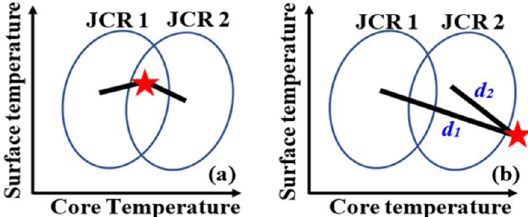
Figure 4. Visual interpretation of fault detection and diagnosis (FDD) algorithm using JCRs. Note that ( a ) represents that a pair of measurements can be found in the overlap of the JCRs, and ( b ) represent that a pair of measurements can be found outside the JCRs due to measurement noise. In addition, d 1 and d 2 in ( b ) represent the distance between the measurements and the centers of JCRs, which can be used for FDD with a minimum distance criterion as defined in Equations (14) and (15).